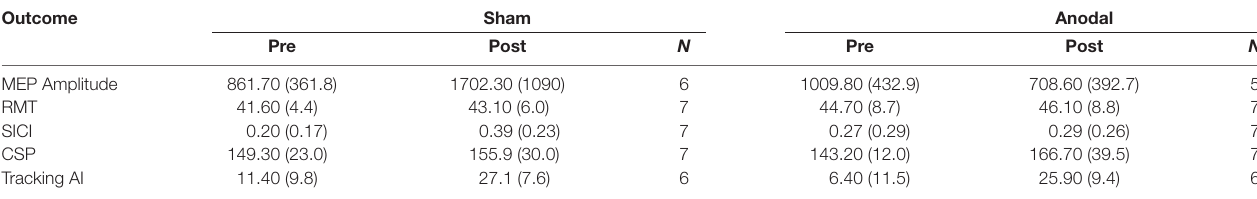
TABLE 1 | Pre-test and Post-test data.